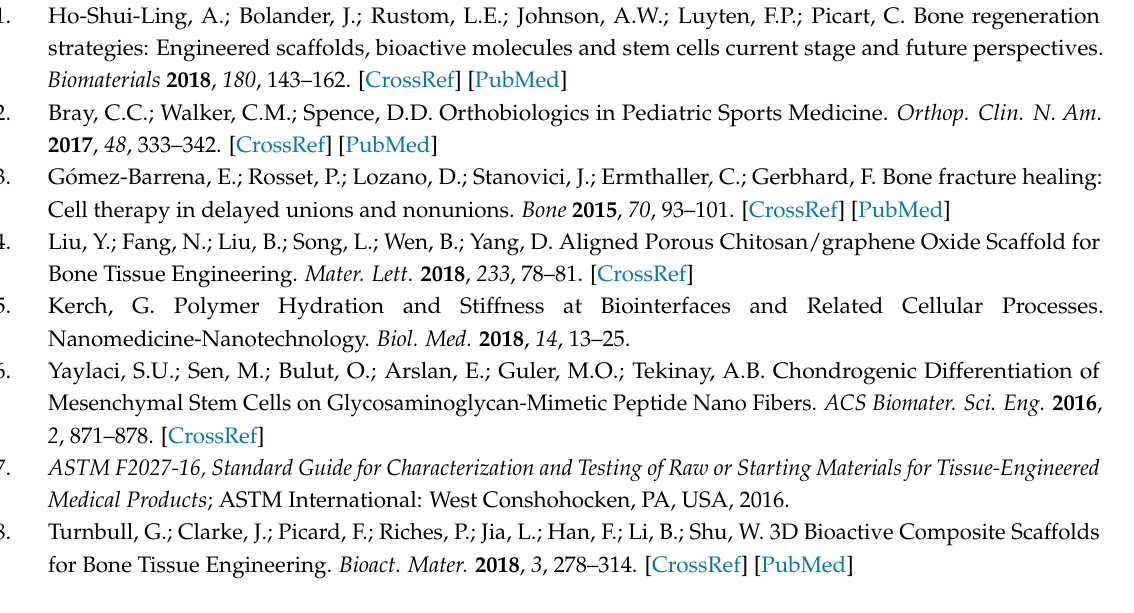
of the CS, Figure S3: FTIR of the CS, Figure S4: Viscosity curve. Specific viscosity vs. concentration, Figure S5: Calibration curve of GPC with pululan standards, Figure S6: Raman of the GO, Figure S7: DLS of the GO, Figure S8: The thermogravimetric curve of CS scaffolds (a) without GO, (b) with 0.5% GO and (c) with 1.0% GO, Figure S9: Degradability test of CS scaffolds in physiological serum (a) without GO, (b) with 0.5% GO and (c) with 1.0% GO